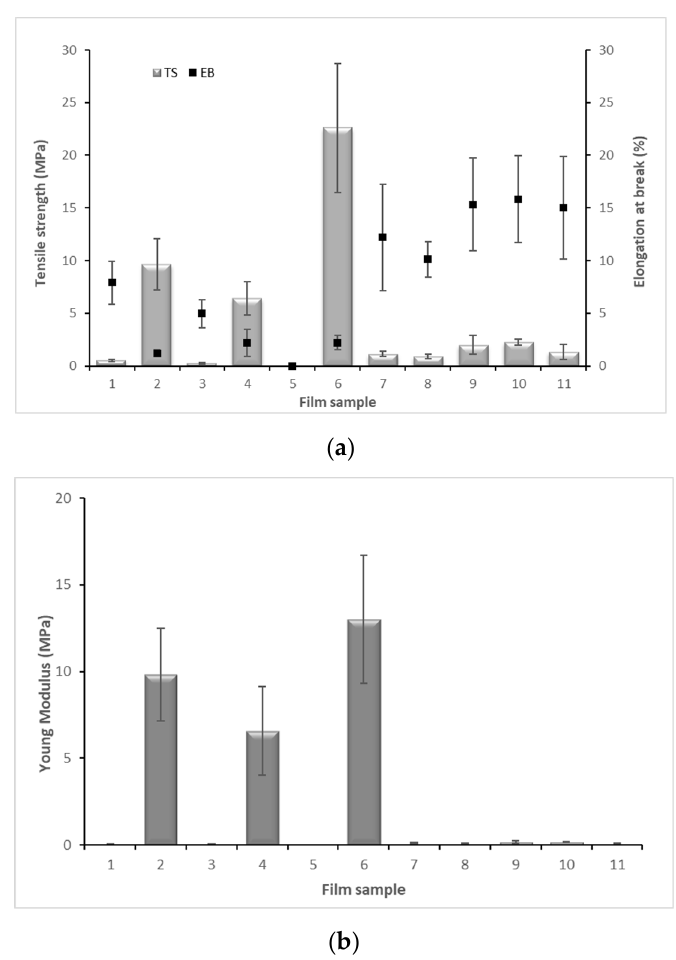
Figure 2. Tensile strength (TS), elongation at break (EB) ( a ), and Young’s modulus (YM) ( b ) of alginate films incorporating amaranth phenolic compounds.